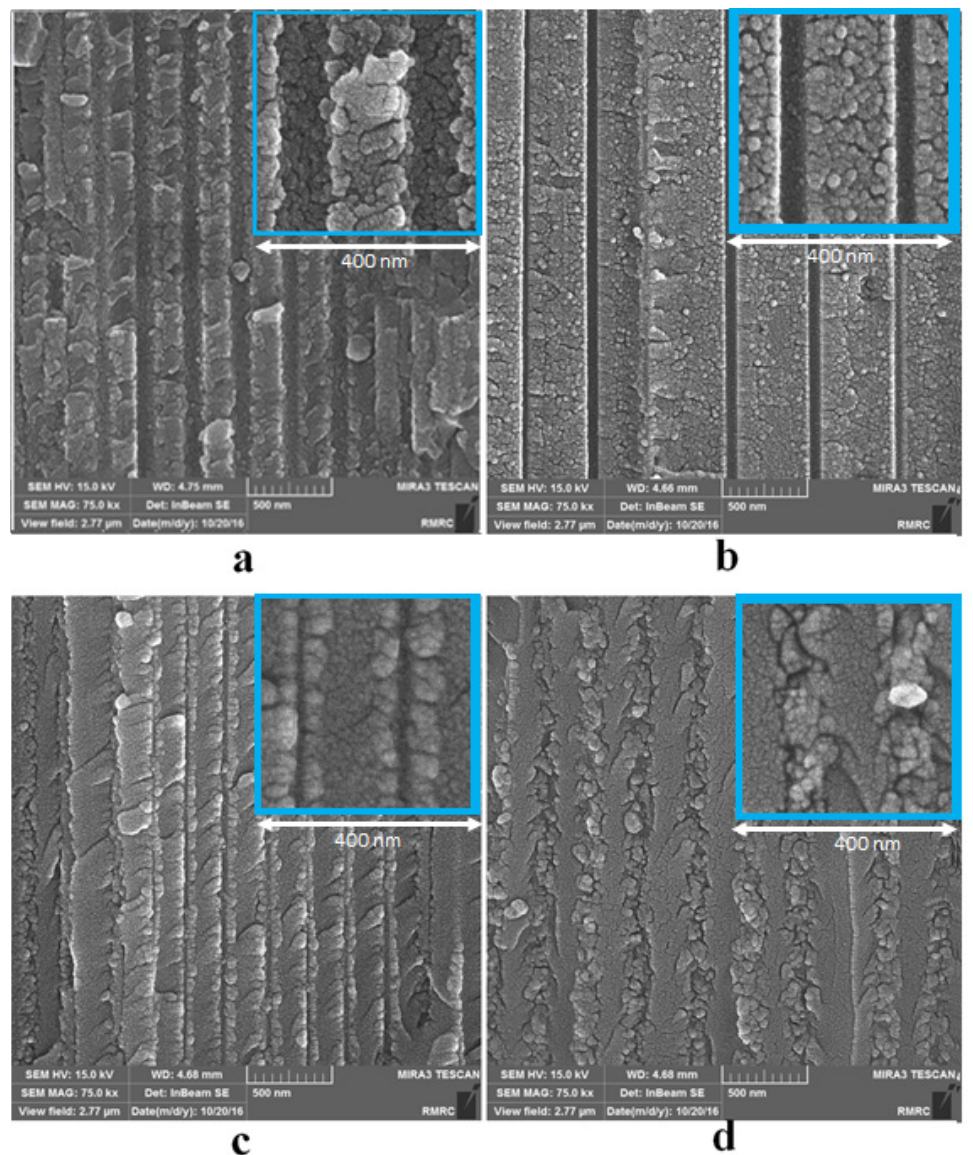
Fig. 4. Cross section FESEM image of alumina doped with (a) Sn during anodization process. (b) tin oxide nanoparticle(p-type). (c) tin oxide nanotube(t-type). (d) tin oxide